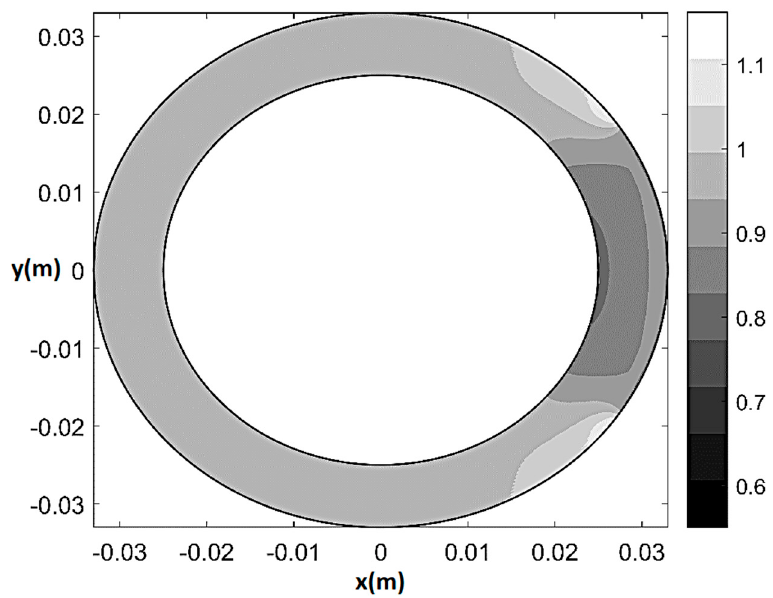
Figure 6. Normalized flow rate contour plot ( U / U H ) at rest for 80% CX stenosis ( q 0 = q 0 H = 2.7 × 10 − 9 m 2 /s, T / T H = 1, ξ = 0.55, Θ s = 72°, δ / δ H = 1).